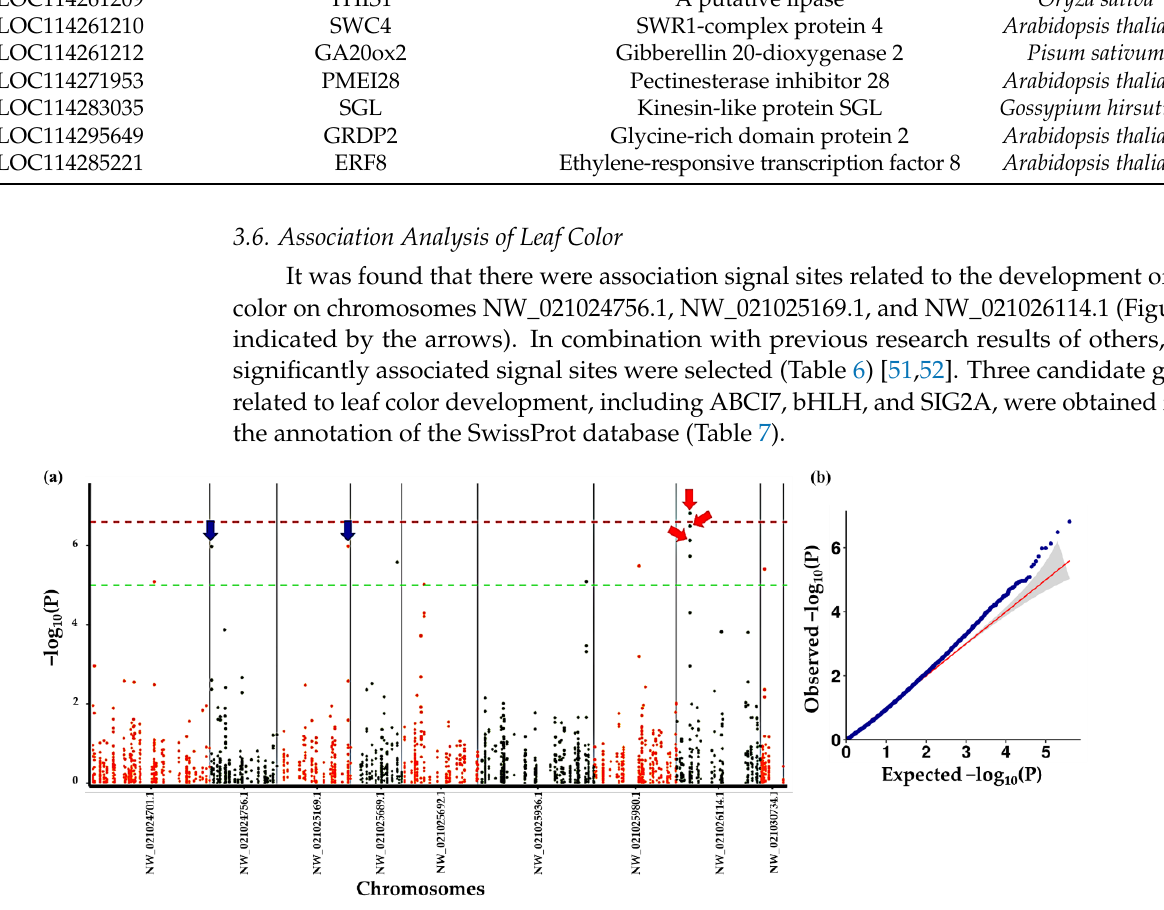
Figure 8. Manhattan plot ( a ) and quantile–quantile plot ( b ) for the leaf color of 125 ancient plants. The abscissa represents scaffold position, and the ordinate represents p -value ( − log 10 (P)), with a negative logarithm (base 10). Scattered points (or lines) on the graph represent − log 10 (P) corresponding to each SNP loci. The green horizontal dashed line corresponds to − log 10 (P) = 5, the red horizontal dashed line corresponds to − log 10 (P) = 7, and the blue horizontal dashed line corresponds to − log 10 (P) =7.5. Red arrows indicate candidate gene loci obtained by screening, and blue arrows show the significant association signal peaks. Table 6. Strong association signal sites and annotation information of leaf color.